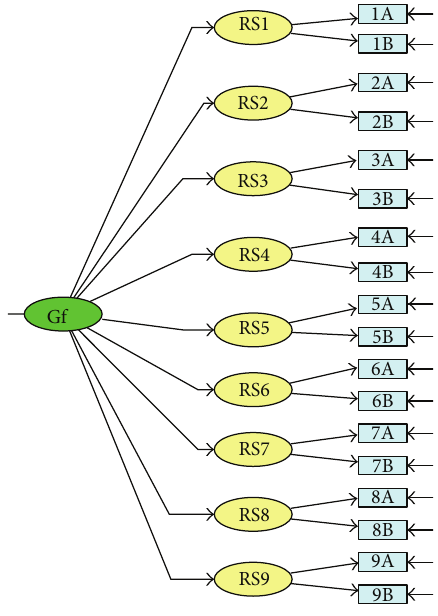
Figure 2: 2nd-order factor model.